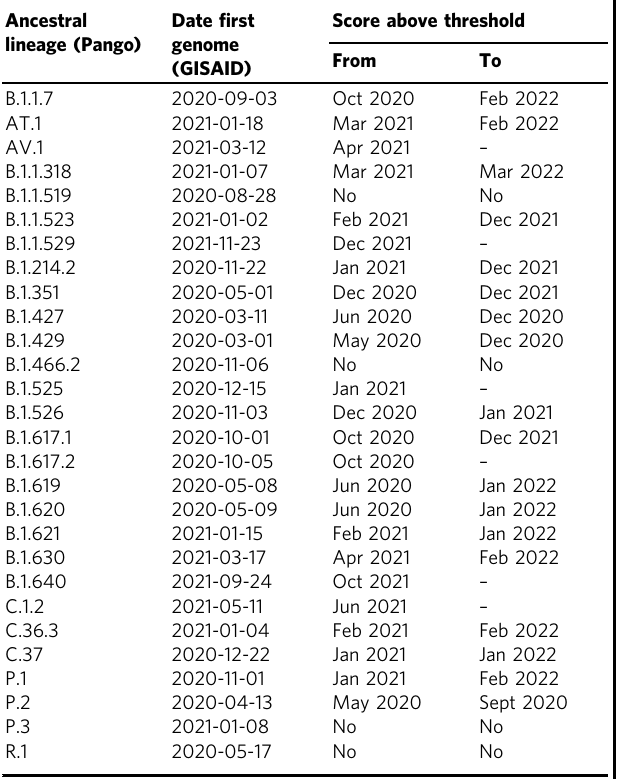
Table 3 Prioritization of VOC/VOI/VUM